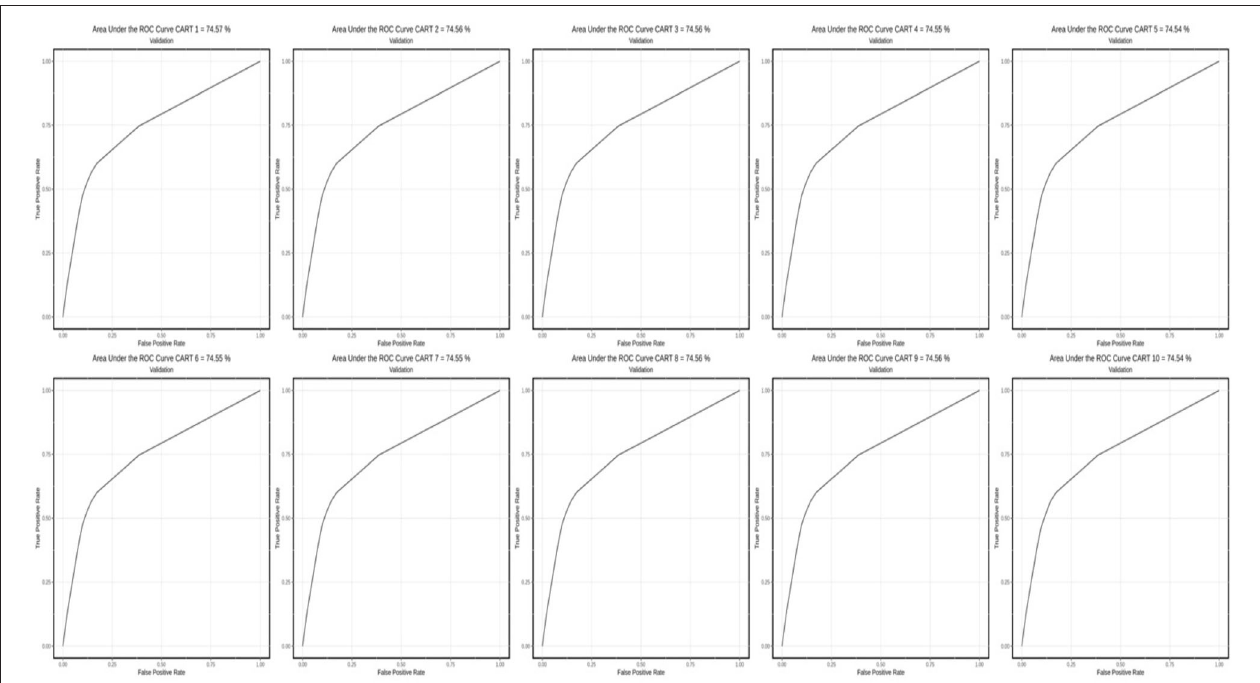
FIGURE 1 | AUC performance of the classification methods with 10-fold CV using the CART method.